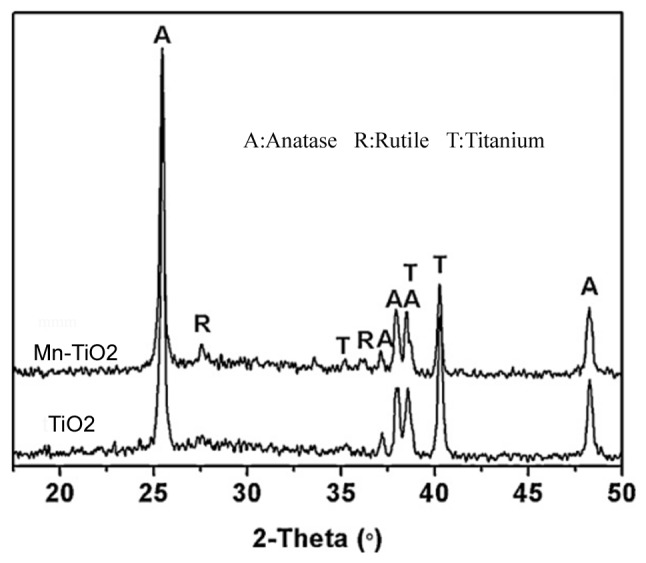
X-ray diffraction patterns of the titanium dioxide (TiO2) and manganese (Mn)-incorporated-TiO2 coatings.